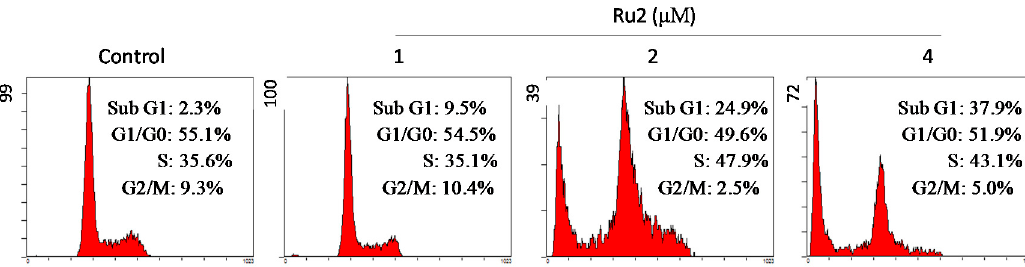
Figure 4. Quantitative analysis of the cell cycle distribution and apoptotic cell death as examined via flow cytometry. Cells were pretreated with or without Ru2 for 24 h.